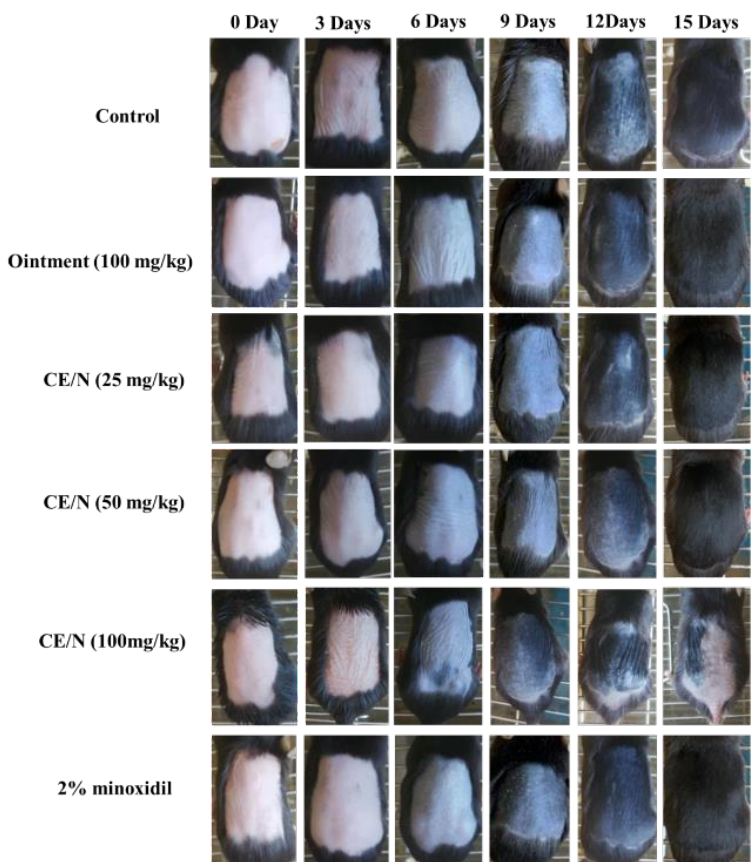
Figure 4. Effects of topical cedrol on hair regeneration in C57BL/6 mice. In vivo hair regeneration was induced by depilating the hairs with a wax/rosin mixture in 6 week-old C57BL/6 mice. The back skin were topically applied with ointment, CE-NE (25 mg/kg, 50 mg/kg and 100 mg/kg), 2% minoxidil ( n = 10). Photographs were taken on 0, 3, 6, 9, 12, 15 days after applying cedrol on the shaved dorsal skin.